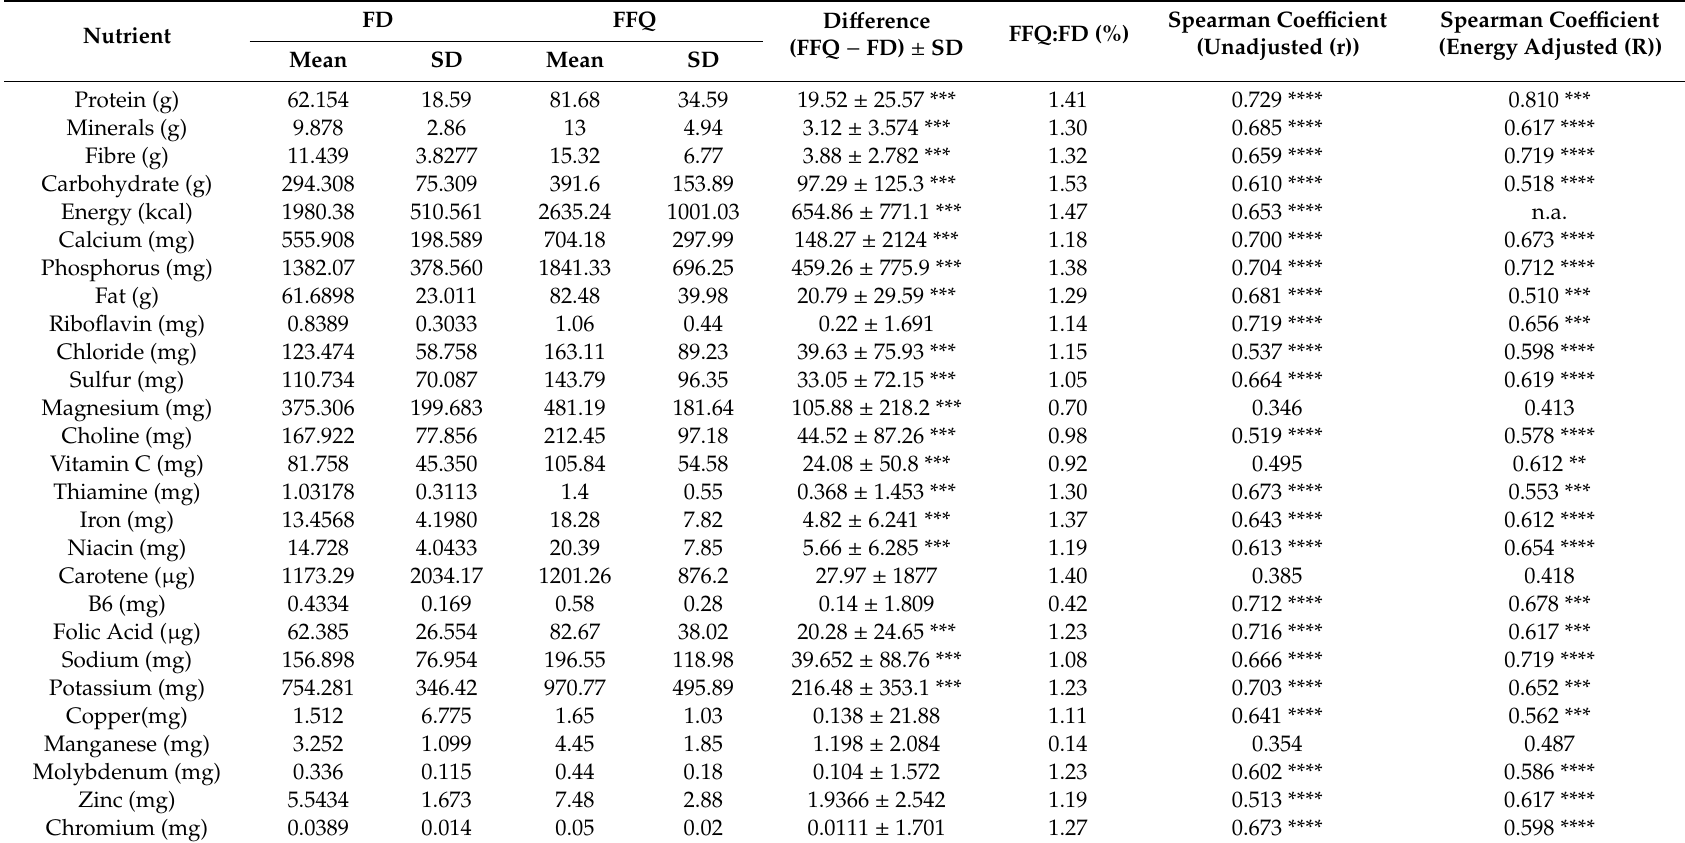
Table 2. Correlation of nutrients estimated by the first food frequency questionnaire (FFQ) and 7-day food diaries